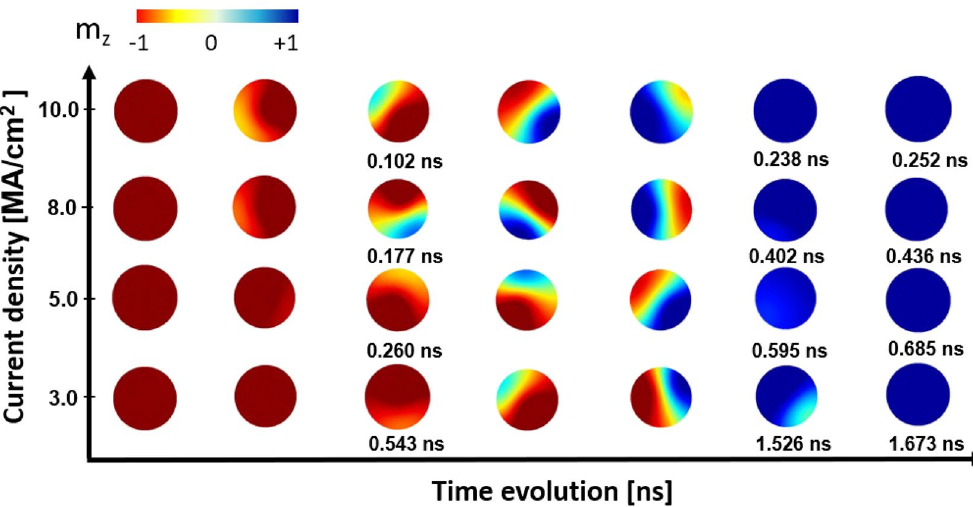
Figure 5. Visualization of the magnetization reversal of the FL magnetization of CoFeB/MgO/CoFeB MTJs with diameter of 30 nm for different injected current densities at 0 K. The color palette describes the z , blue z , green = in-plane). z-component of the magnetization (red = − = +